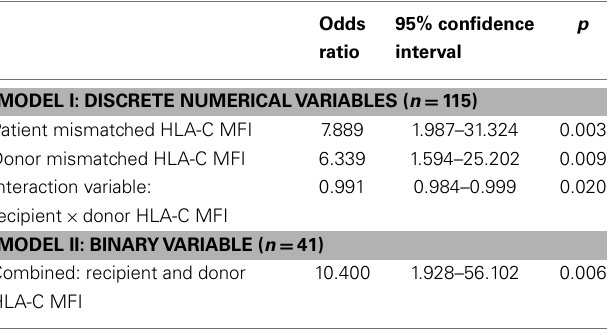
Table 2 | Multivariate logistic regression analysis for prediction of CTLp outcome